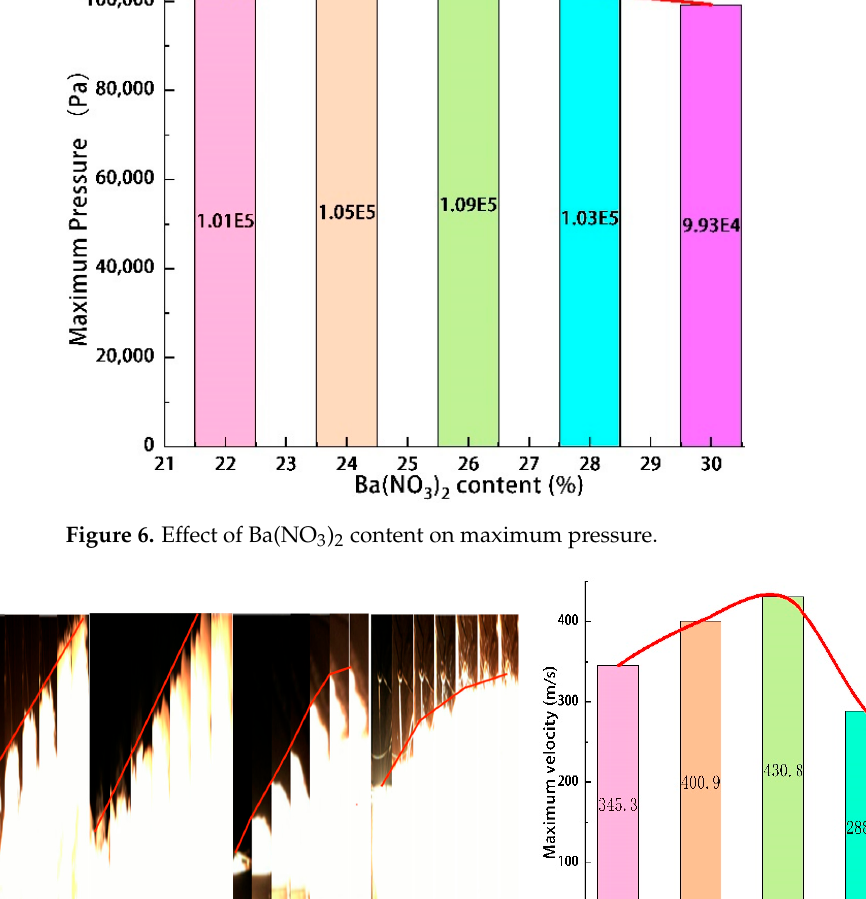
Figure 5. Effect of Ba(NO 3 ) 2 content on maximum temperature.